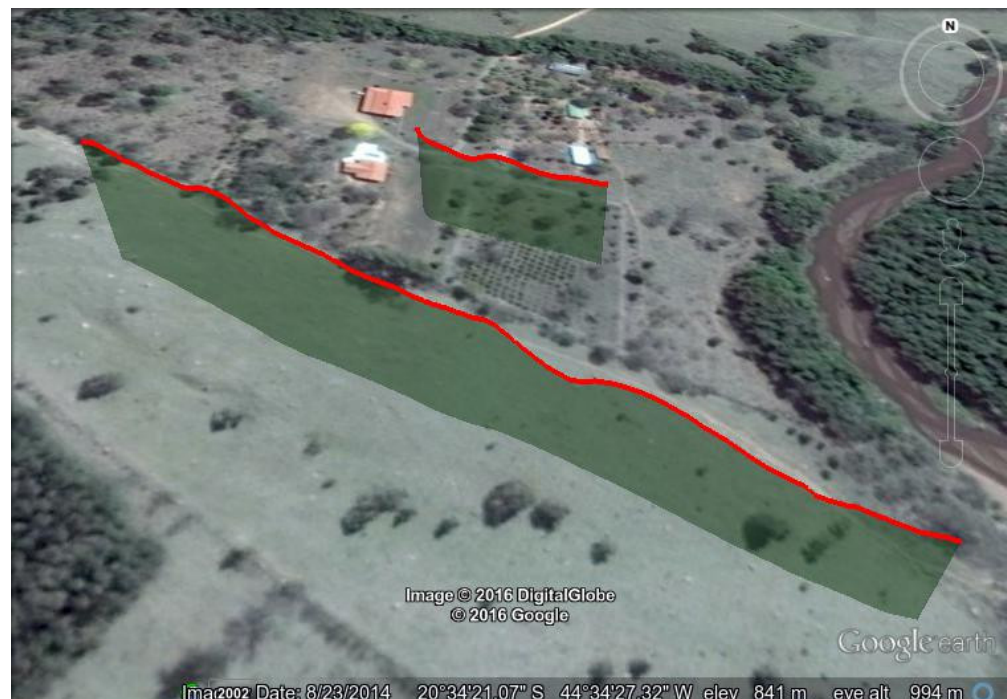
Figure 10. Hill flight path from GPS data of the telemetry logs. This image is from a perspective view, where the red lines represent the flight paths of the two areas of interest and the green shade the projection of this flight path on the Earth’s surface.